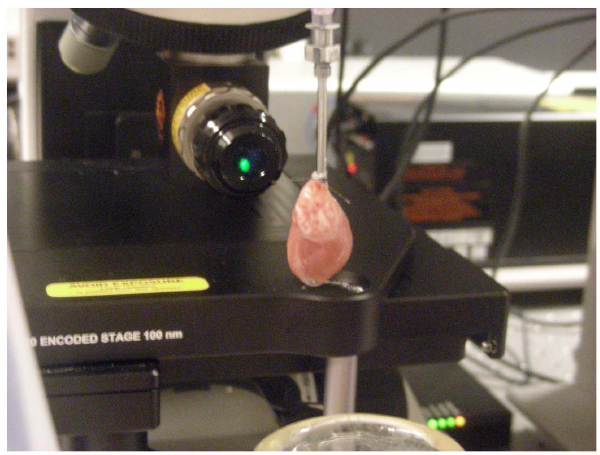
Figure 1. Heart position with respect to the objective and laser light. An isolated heart is attached to the perfusion system through an aortic cannula for retrograde perfusion. Excitation and registration of the Raman scattering is done through the objective.